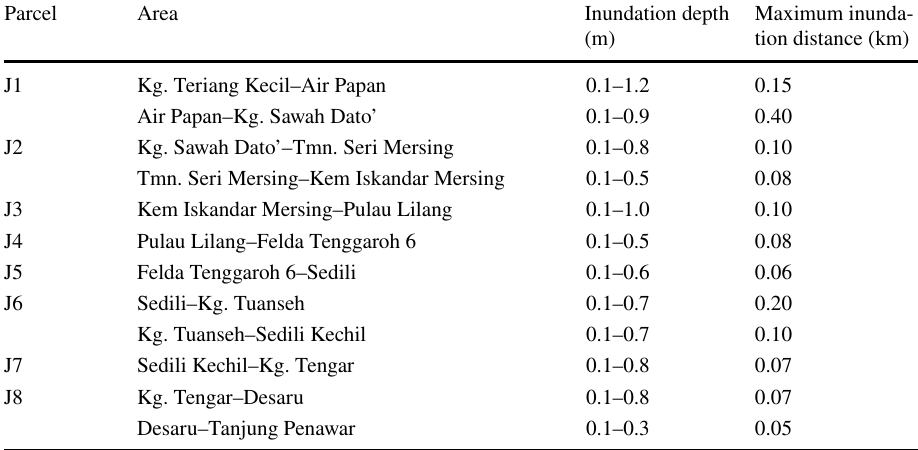
Table 7 Inundation depths and inundation distances in Johor at Mw